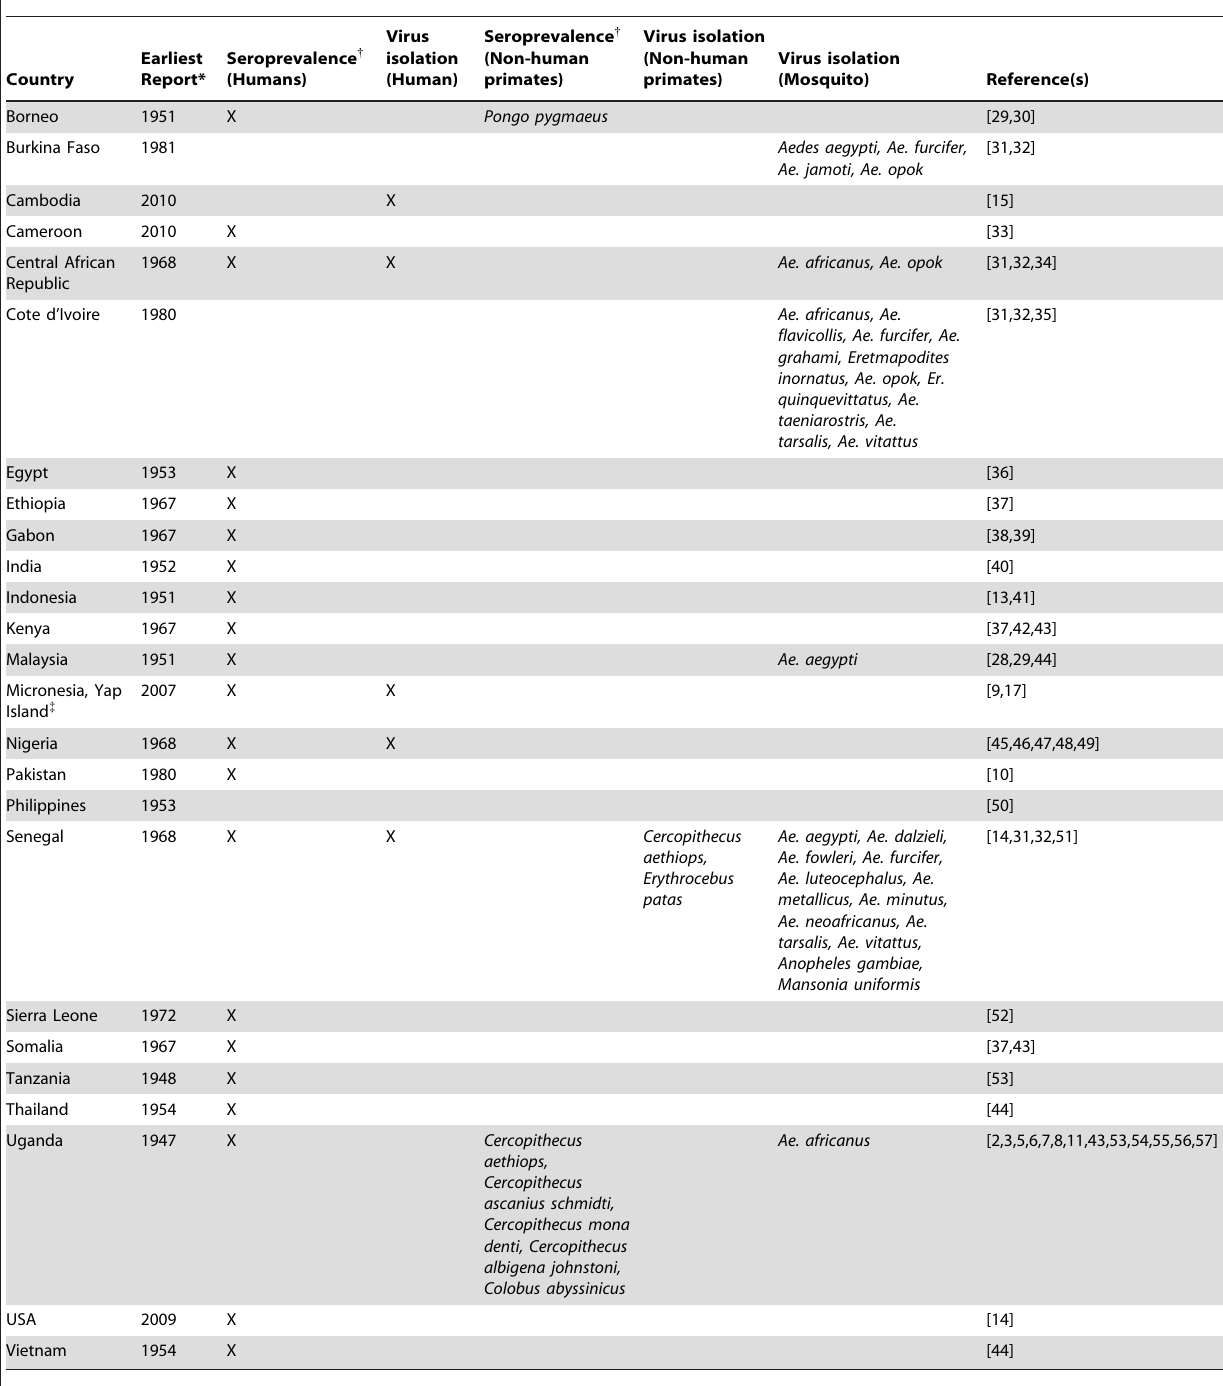
Table 1. Probable distribution of Zika virus based on virus isolation and seroprevalence.